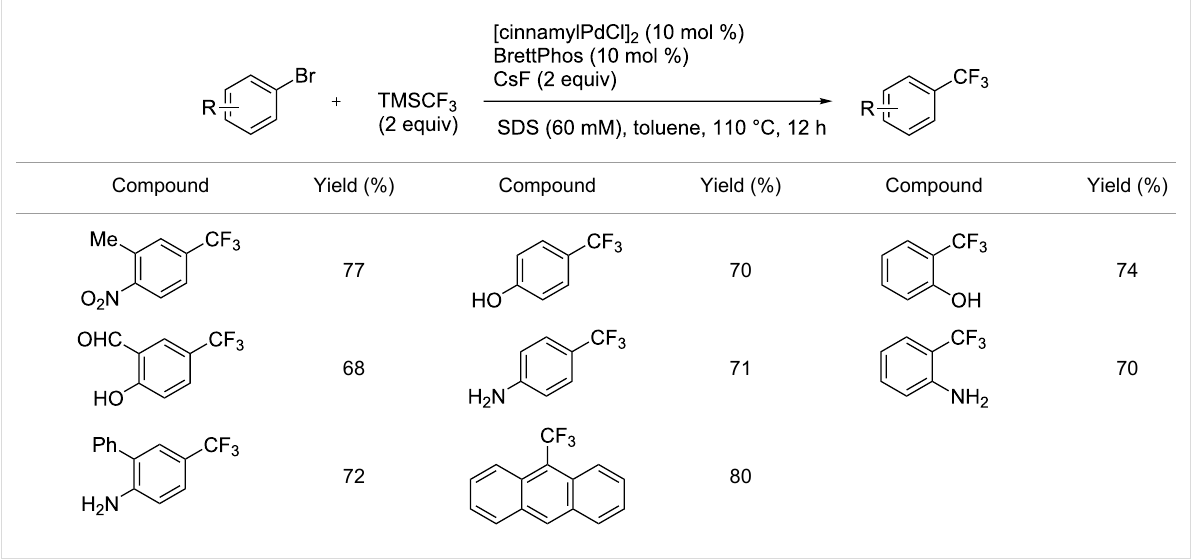
Table 3: Pd-catalyzed trifluoromethylation of bromoaromatic compounds in micellar conditions [65].